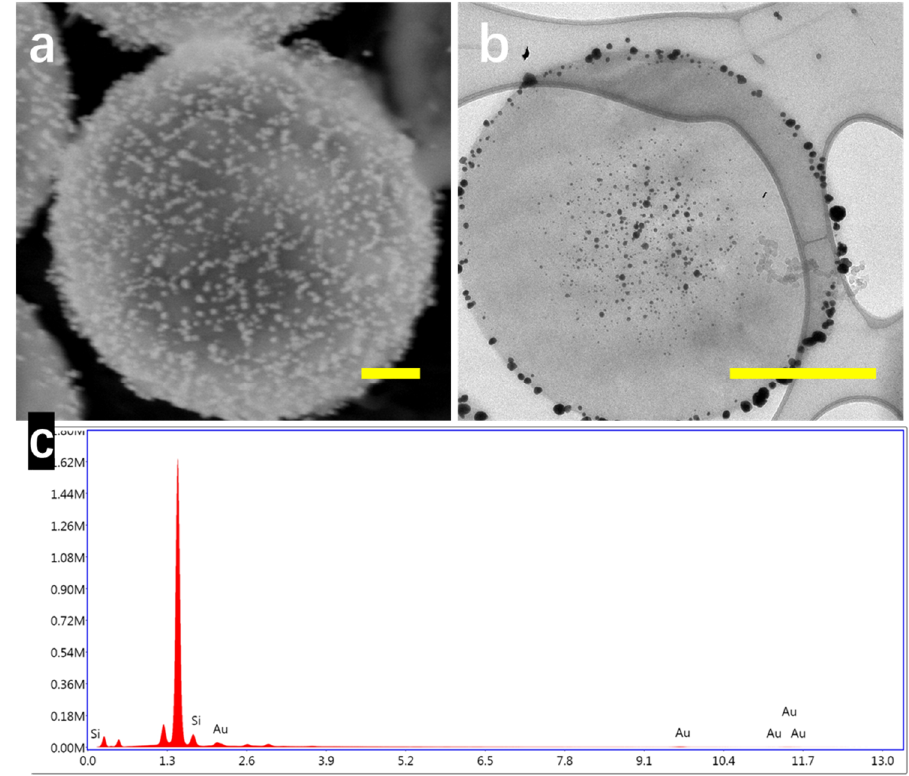
Figure 3. ( a ) SEM image of hollow SiPM/Au composite; ( b ) TEM image of SiPS/Au composite; and ( c ) EDS spectra of hollow SiPM/Au composite. Scale bar: 500 nm.